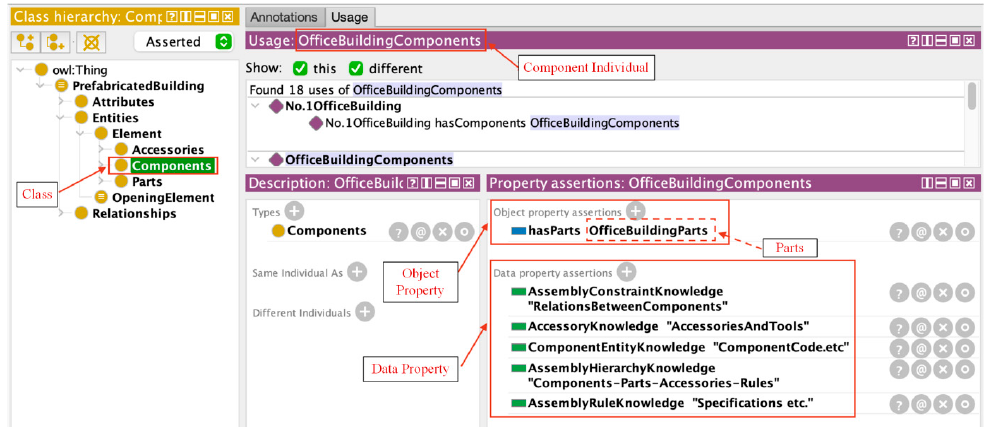
Figure 22. Component individual creation.